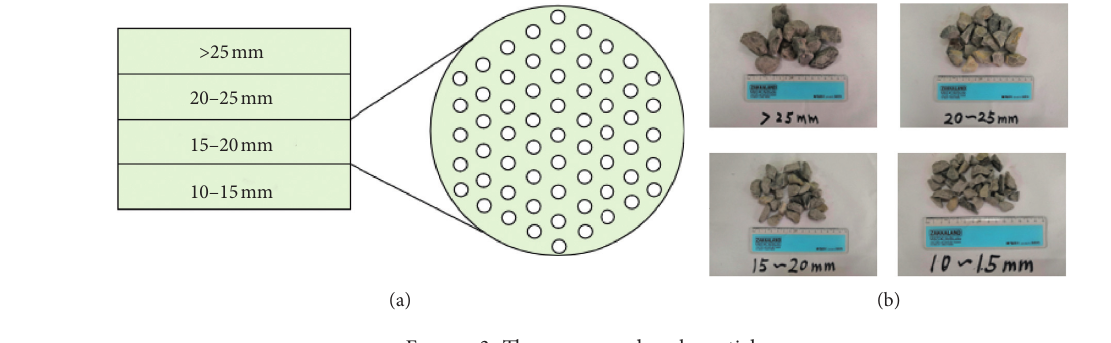
Figure 3: The screen and rock particles.